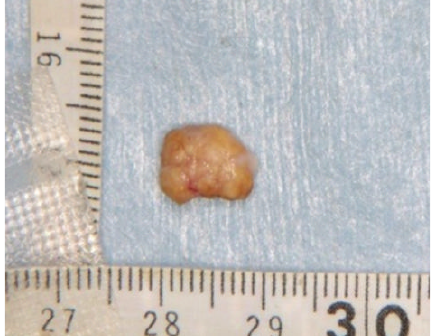
Figure 3: The excised specimen was hard and yellowish white 10 × 9 mm in size, and the cross section showed a coarse and bone-like surface.